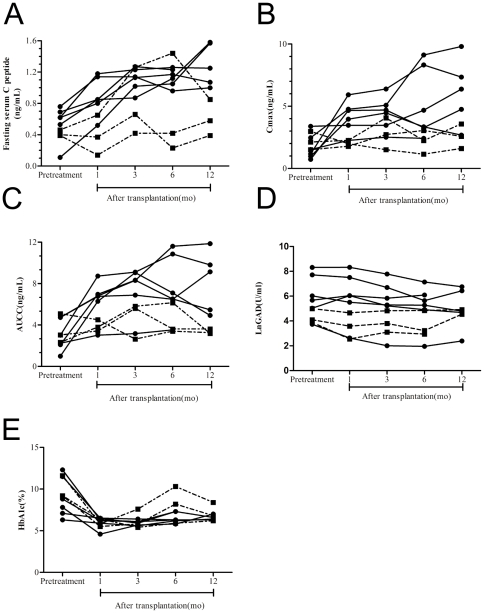
Time course of fasting C-peptide (A), Cmax (B), AUCC (C), GADA (D) and HbA1c (E) in IF group and ID group respectively.Black circles, insulin free. Black squares, insulin dependent. X axis represents the time course relative to HSCT. A p<0.05, pre-treatment vs all follow-up time in IF group; IF vs ID group at 1 month and 12 months post-treatment. B p<0.05, pre-treatment vs all follow-up times in IF group; IF vs ID group at one month and six months post-treatment. C p<0.05, pre-treatment vs all follow-up times in IF group; IF vs ID group at 12 months post-treatment. D p = 0.036, IF vs ID group at six months post-treatment.